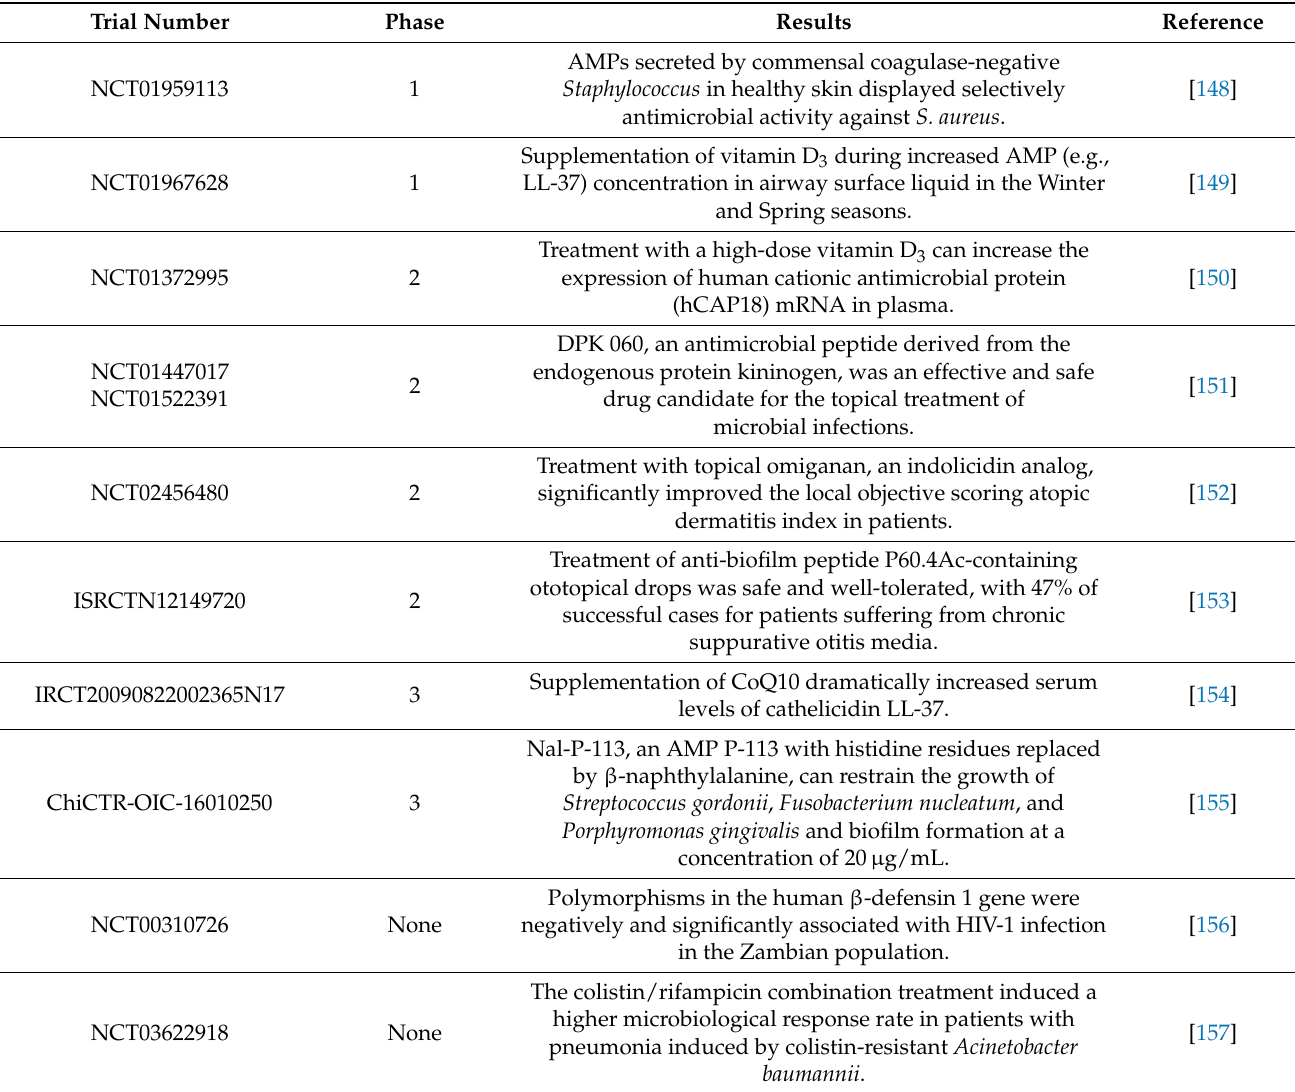
Table 3. Completed clinical trials with studies relative to